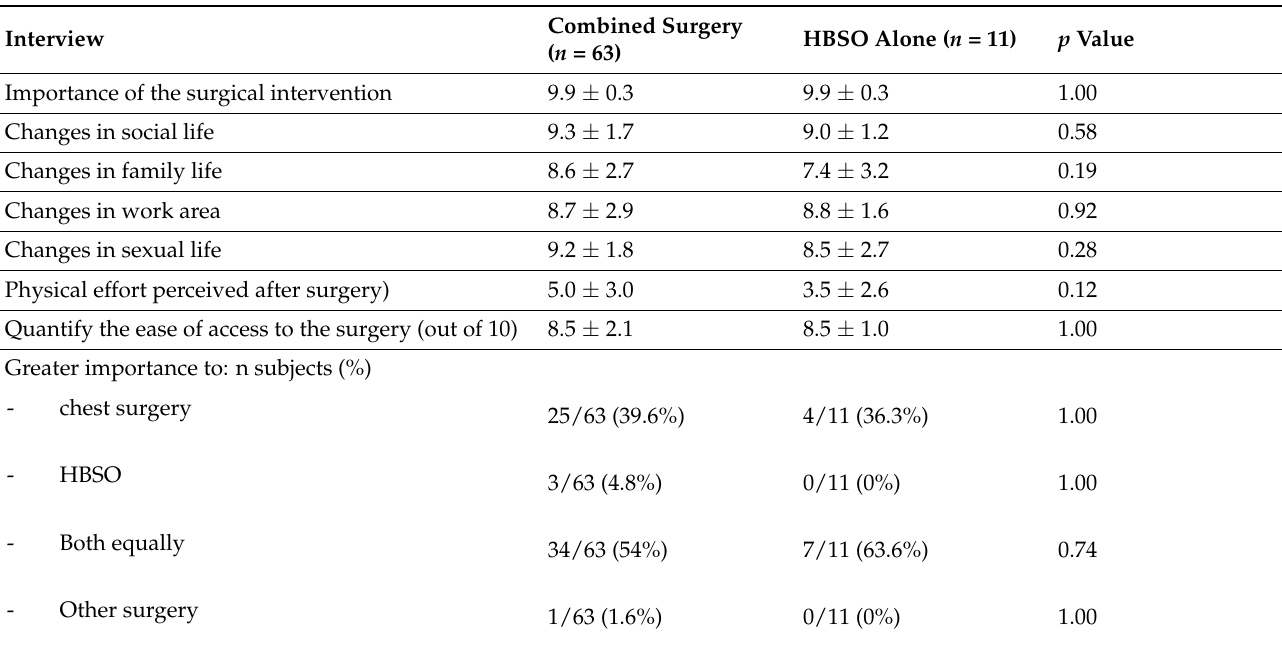
Table 5. Responses to the semi-structured interview regarding importance and impact of the intervention (score range from 0 = no change/importance to 10 = maximum